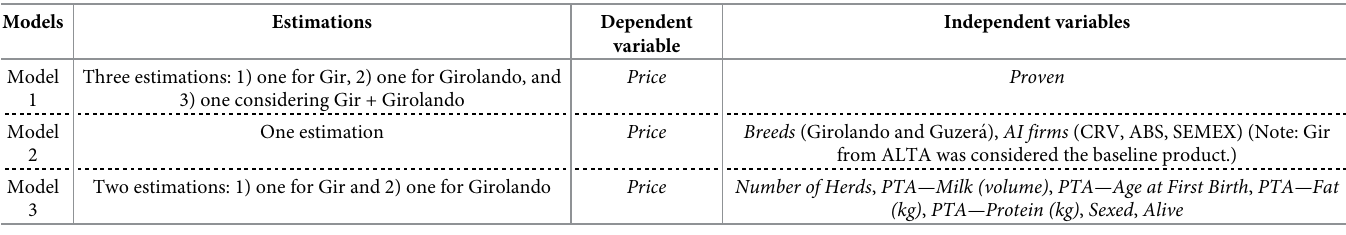
Table 2. Models and variables used in the